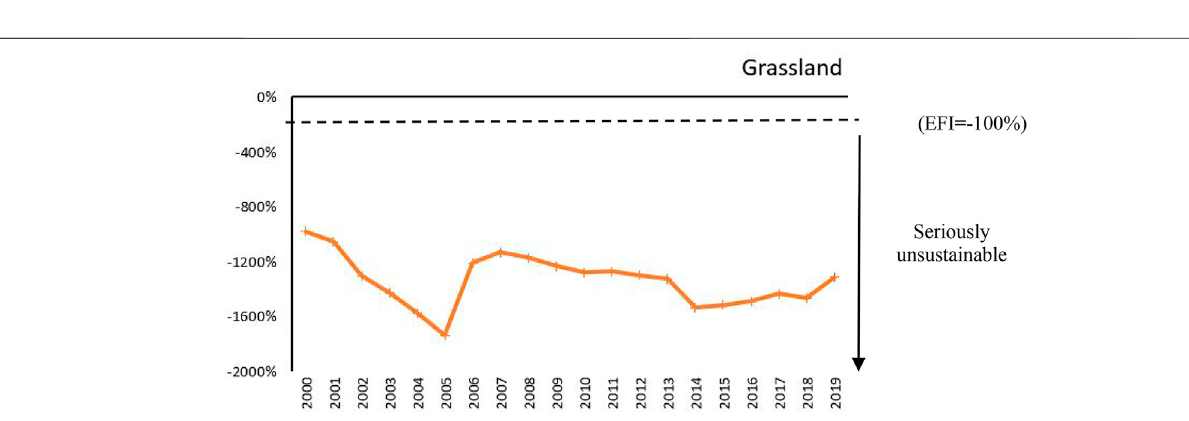
FIGURE 8 | Trend map of the EFI of grassland.